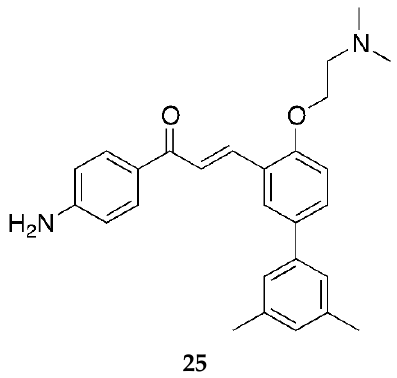
Figure 20. Chemical structures of the 4-aminochalcone derivate.